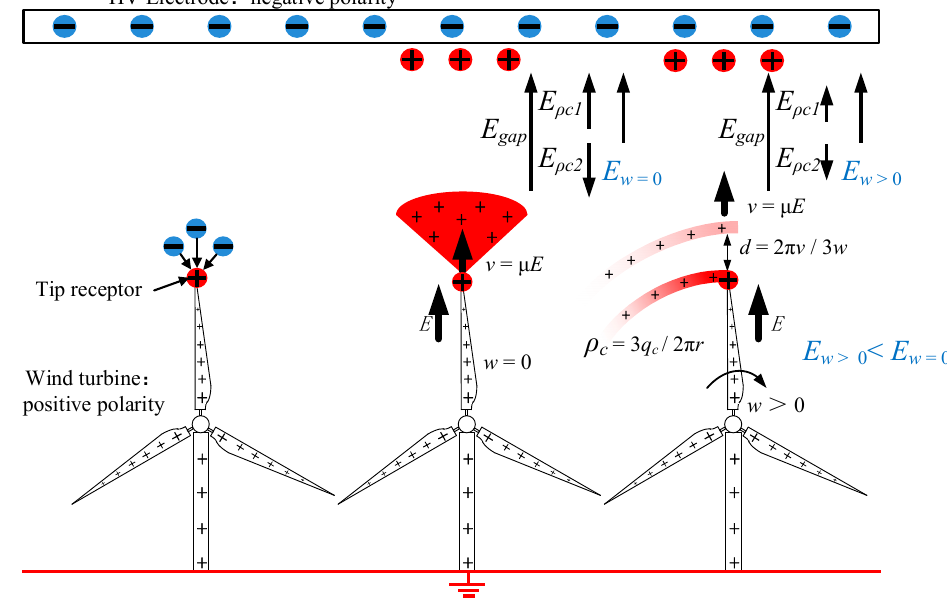
Figure 10. Schematic diagram of space charge distribution in static and rotating wind turbine. (refer to reference [14]). E ρ : electric field strength of the gap; E ρ c 1 : electric field strength outside of the tip area; E ρ c 2 : electric field strength of the tip area; E w=0 : overall intensity of the applied electric field under w = 0 r/min; E w>0 : overall intensity of the applied electric field under w > 0 r/min; ρ c : charge density near the blade tip; v : the drift velocity of the positive ions.